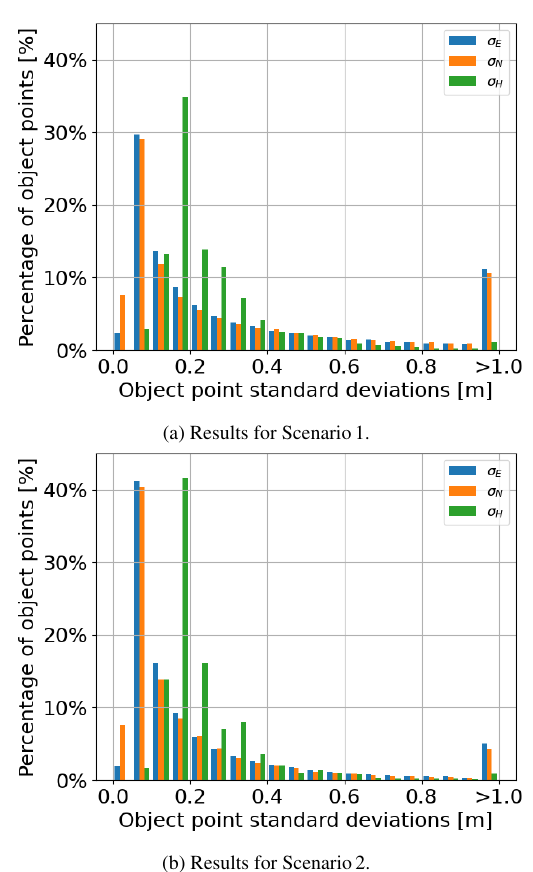
Figure 9. Histograms of the standard deviations of the 3D coordinates of the tie points for Scenarios1 and 2.